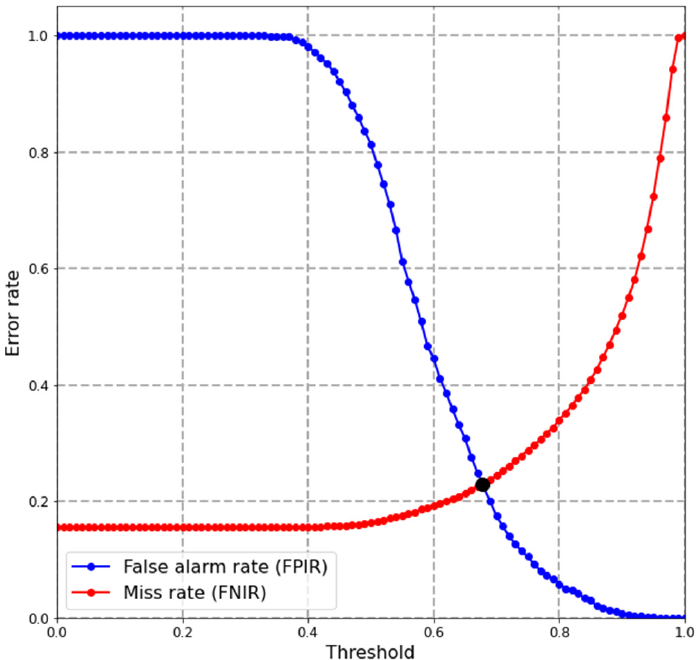
Figure 7. Detection error trade-off (number of identity N = 89, top R = 1, number of images per identity nim = 25) characteristics of identification system on test set.